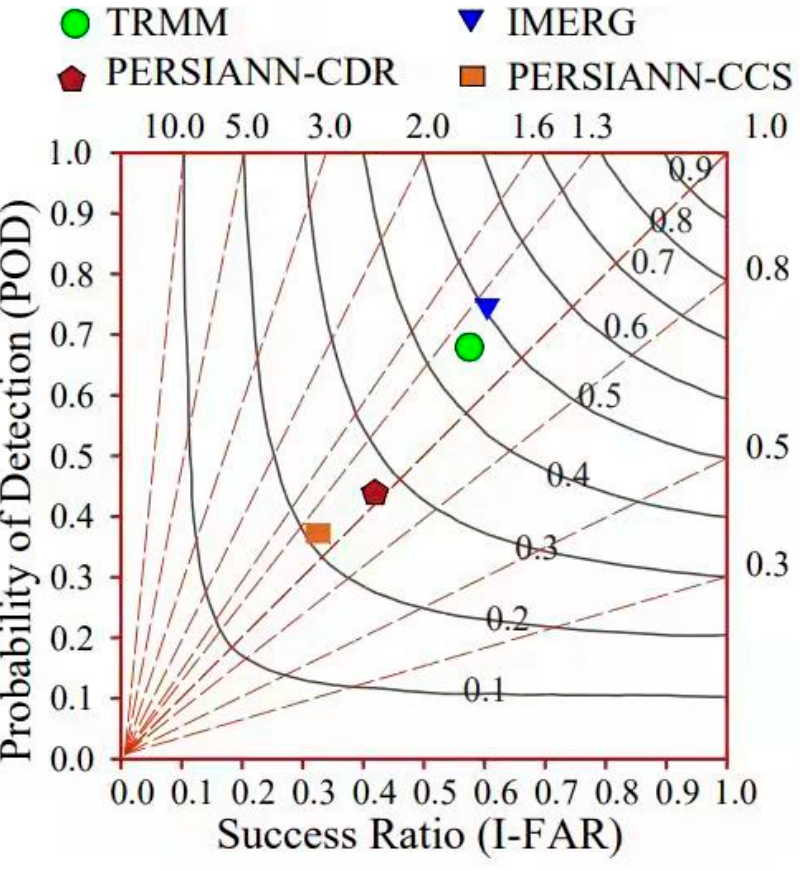
Figure 11. Taylor diagram showing the performance of daily estimation of SBPD.